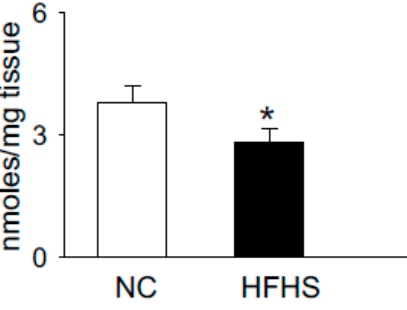
Figure 1. High-fat high-sucrose (HFHS) feeding to wild type (WT) mice decreases histidyl dipeptides in skeletal muscle. WT C57Bl6 mice (8 weeks old) were fed with normal chow (NC) and high-fat high-sucrose feeding for 12 weeks. Gastrocnemius muscles were isolated from the mice after NC and HFHS feeding, which were analyzed by LC–MS for anserine and carnosine levels, using tyrosine histidine as an internal standard. Data are presented as mean ± SEM, n = 5–6 mice in each group, * p < 0.05 vs NC.